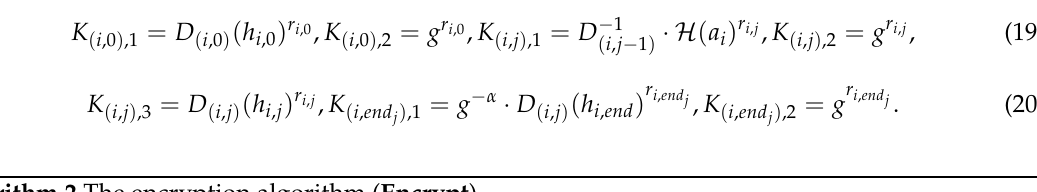
Algorithm 2 The encryption algorithm ( Encrypt